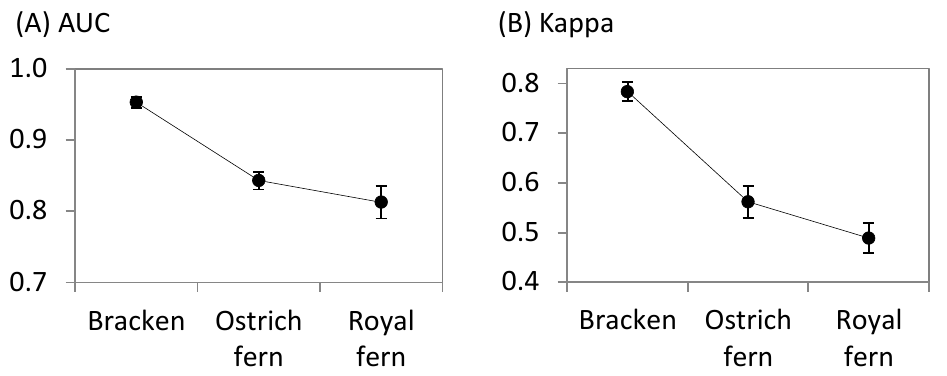
Figure 2. Model accuracy measured by ( A ) the area under the receiver operating characteristic (ROC) curve (AUC) and ( B )